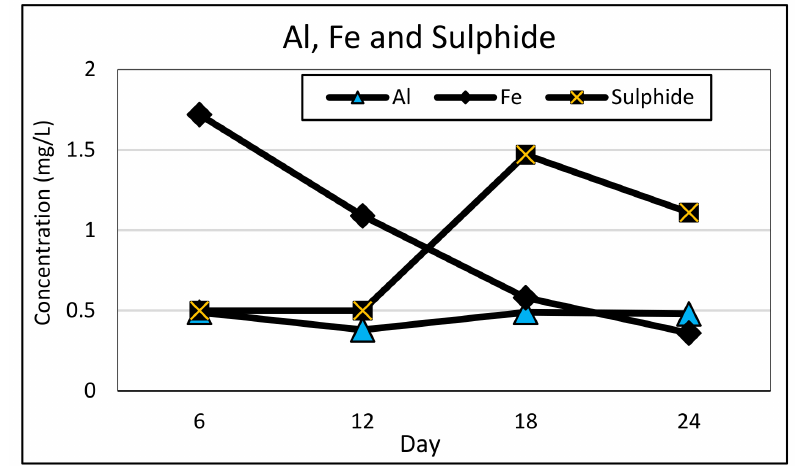
Figure 10. Treated Al, Fe, S 2 − , and